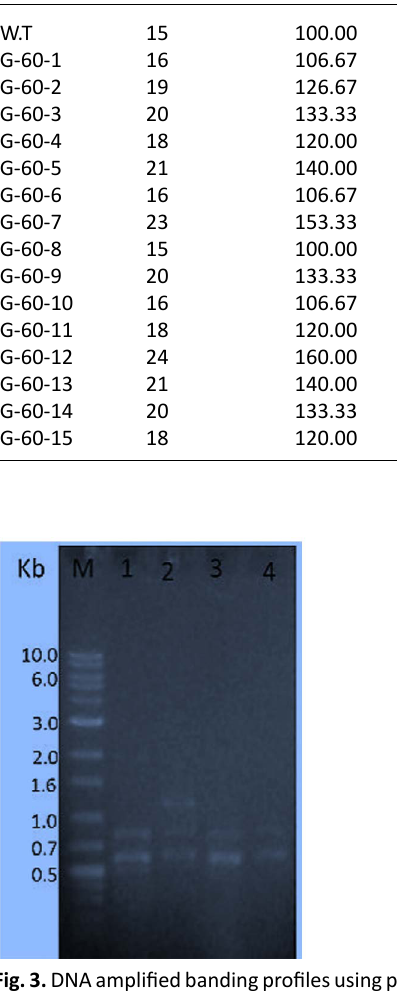
Fig. 3. DNA amplified banding profiles using primer (R2) based on RAPD for three Superior mutants (Lanes 2 to 4) and S. albogriseolus W.T (lane 1) opposite to Sizer™ -1000 plus DNA Marker (lane M). Superior mutants sequence as follows: T-40-22, T-40-29 and G-60-12.